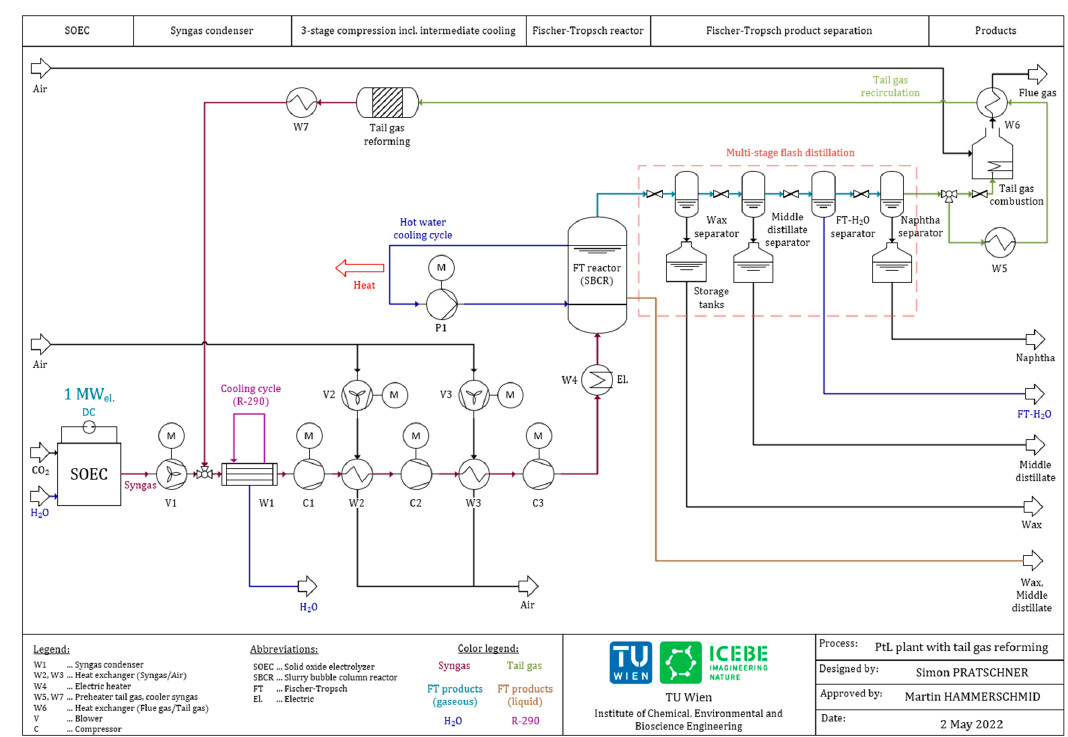
Figure 1. Scheme of the Power-to-Liquid plant without tail gas reforming.